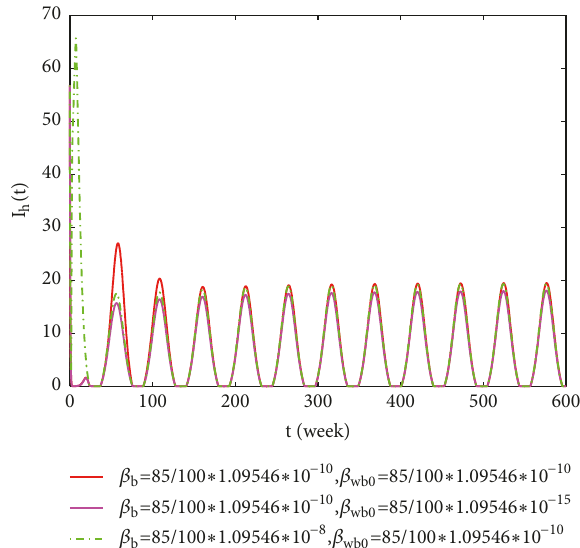
Figure 7: The curve-trend diagram of 𝐼 ℎ with time, when 𝛽 𝑏 or 𝛽 𝑤𝑏 takes different values.